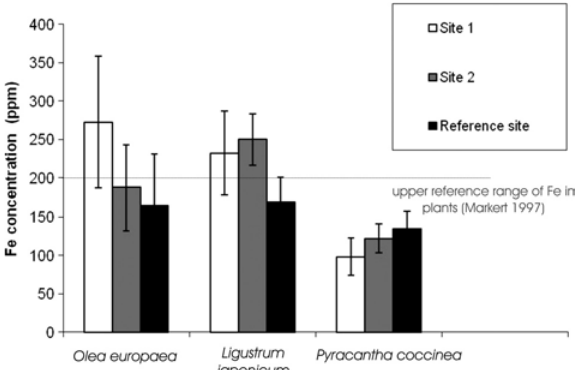
Fig. 5. Iron concentrations (ppm dry wt) in the leaves of Olea europaea , Ligustrum japonicum, and Pyracantha coccinea from different studied sites (site 1: industry; site 2: traffic; reference site: botanical garden)